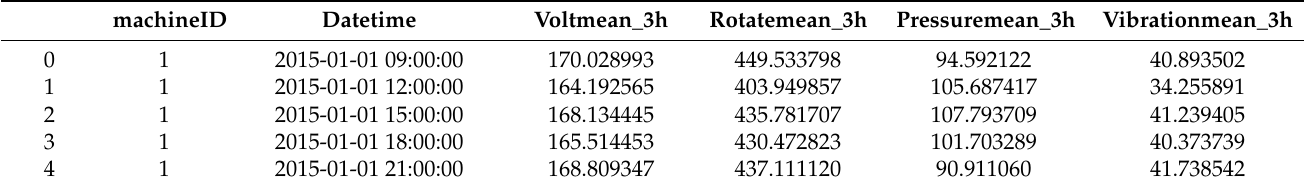
Table 7. Example of Lag Features for telemetry data in real time, with N = 3.